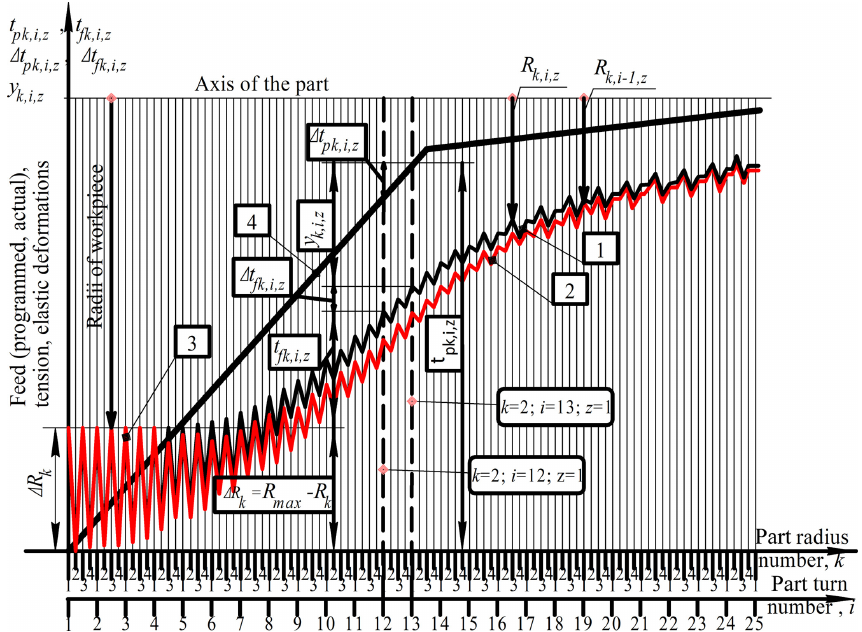
Figure 1. Calculation scheme of the relationship between feeds, elastic deformations and current radii at round grinding with radial feed: (1) trajectory of the radius of the part and the actual position i while turning; (2) trajectory of the radius of the part and the actual position i − 1 while turning; (3) interrupted cutting zone; (4) programmed feed